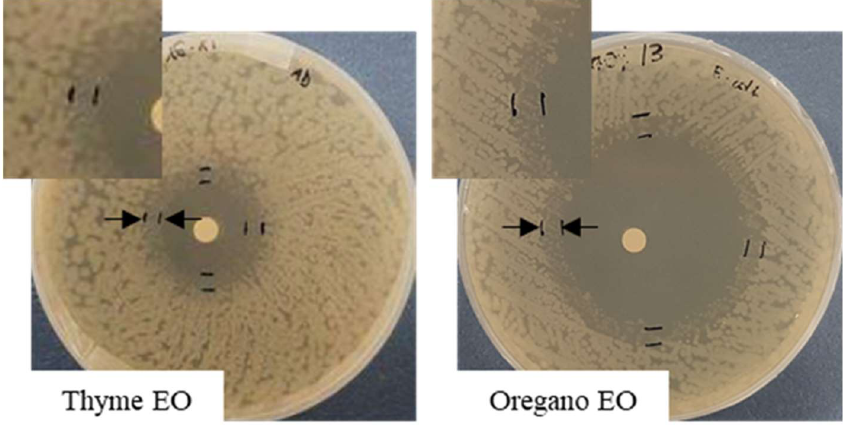
Figure 3. “Faint” microbial growth, shown between arrows and enlarged in the photo details, for E. coli growth in the presence of EOs in the disk diffusion assay.